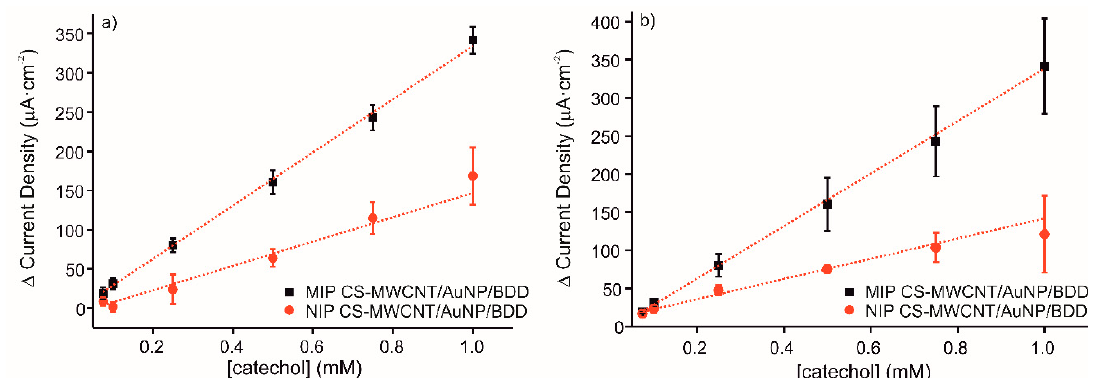
Figure 5: Calibration curves of MIP CS-MWCNT/AuNP nanocomposite/BDD sensor in black and NIP CS-MWCNT/AuNP nanocomposite/BDD sensor in red in 0.1 M, pH 7.4 PBS solution for increased concentration of catechol (0.075, 0.1, 0.25, 0.5, 0.75, and 1 mM) for ( a ) three sensors prepared under the same conditions and ( b ) the same sensor measured three times.